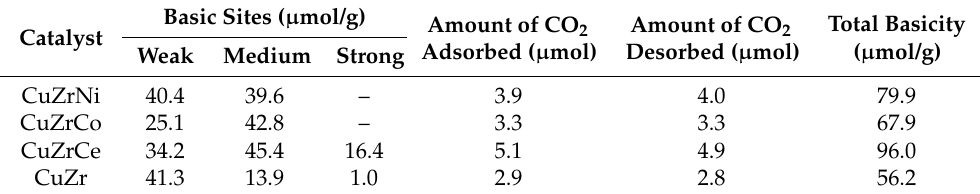
Table 2. Quantitative analysis of basic sites for synthesized catalysts.